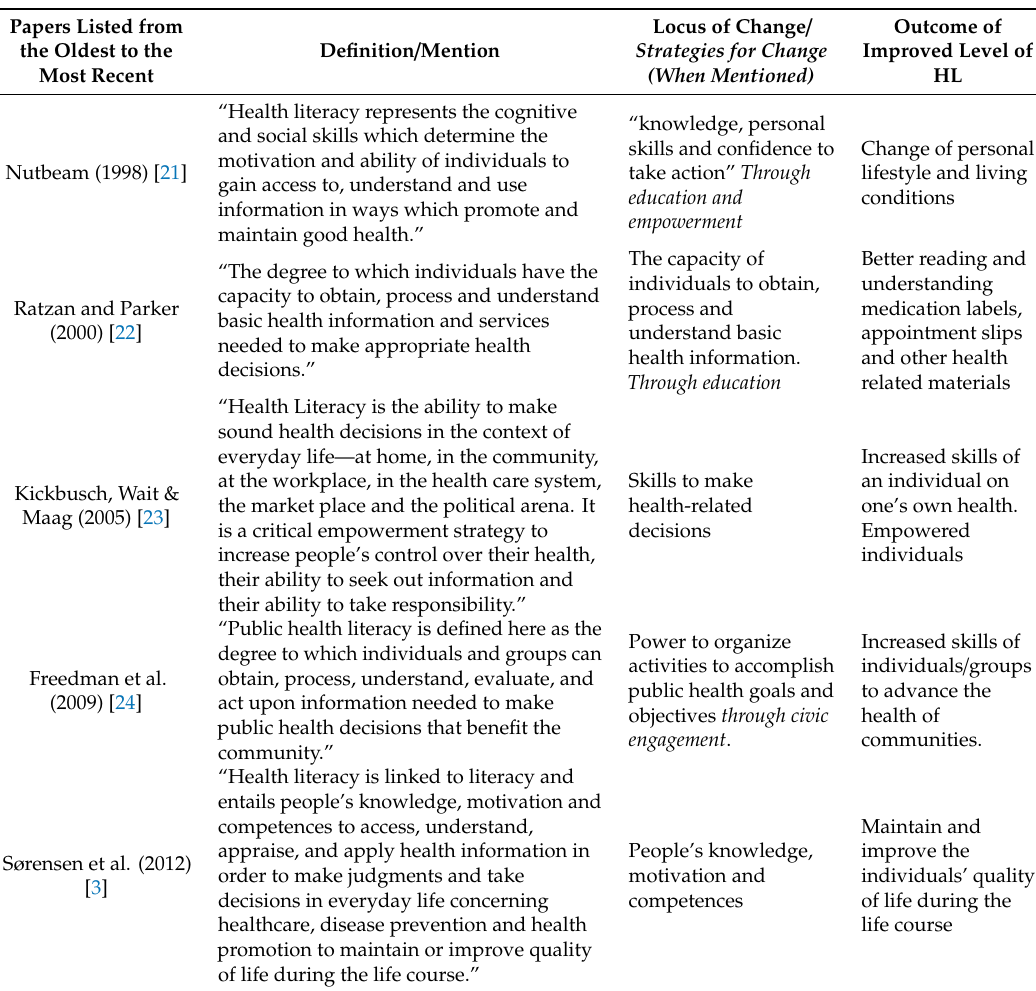
From patient education to health literacy: a selection of definitions quoted in the scientific